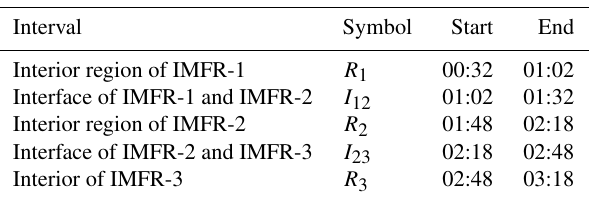
Table 2. Timing of the five selected regions during the triple-IMFR event on 2 February 2002.